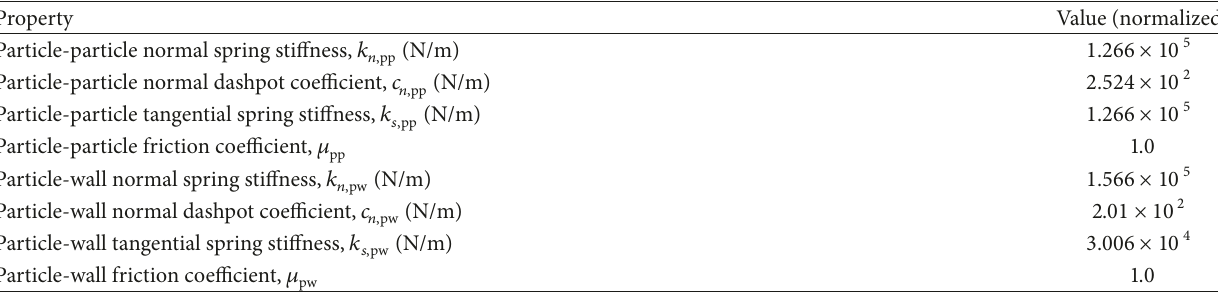
Table 2: Mechanical properties of